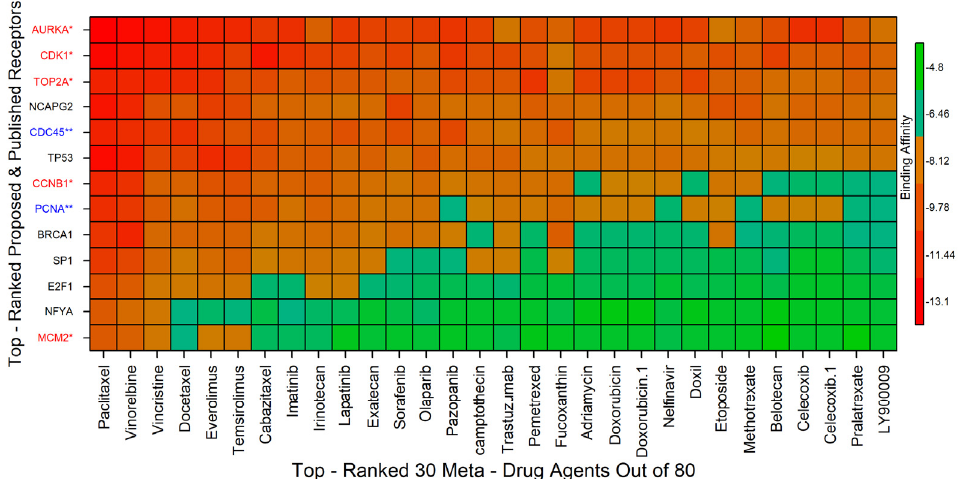
Figure 6. Image of binding affinities based on the top-ordered 30 meta-drug agents out of 80 against the ordered 13 receptors, where red colors indicated the strong binding affinities. The red color with a single star (*) indicated common receptors (published and proposed), the blue color with a double star (**) denoted only published receptors, and the receptors with the black color indicated only proposed receptors.